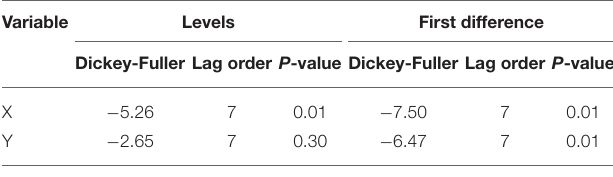
Alternative hypothesis: Stationary. TABLE 2 | Results of the COVID and PKUSD using PP test. Variable Levels First difference